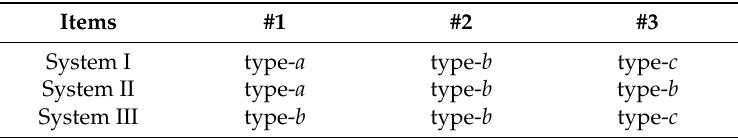
Table 2. System construction.